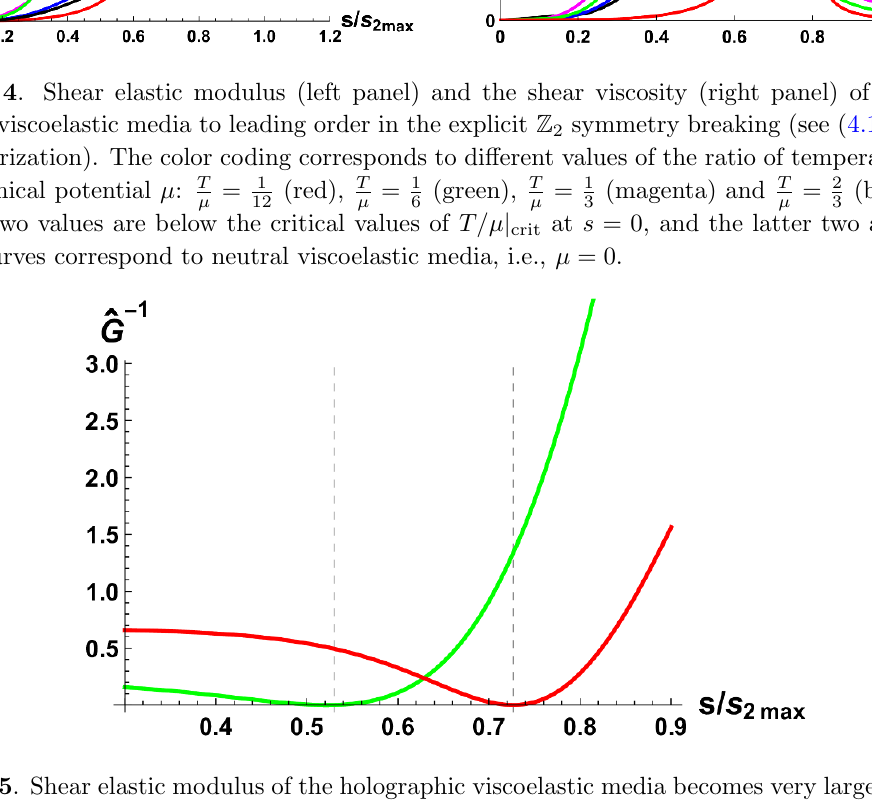
= 1 (red), T = 1 (green) | both below (cid:22) 12 (cid:22) 6